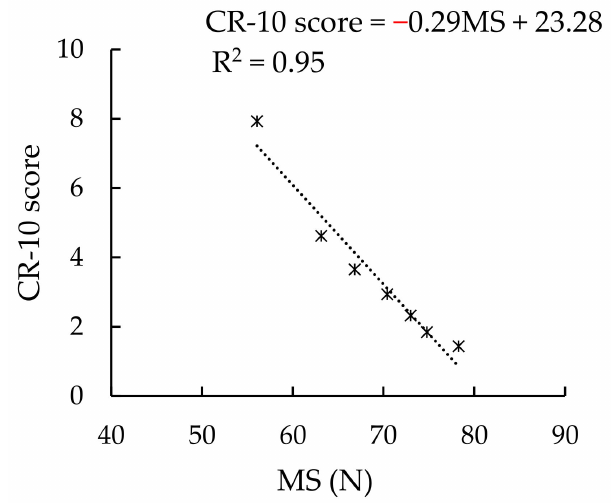
Figure 9. CR-10 score- MS